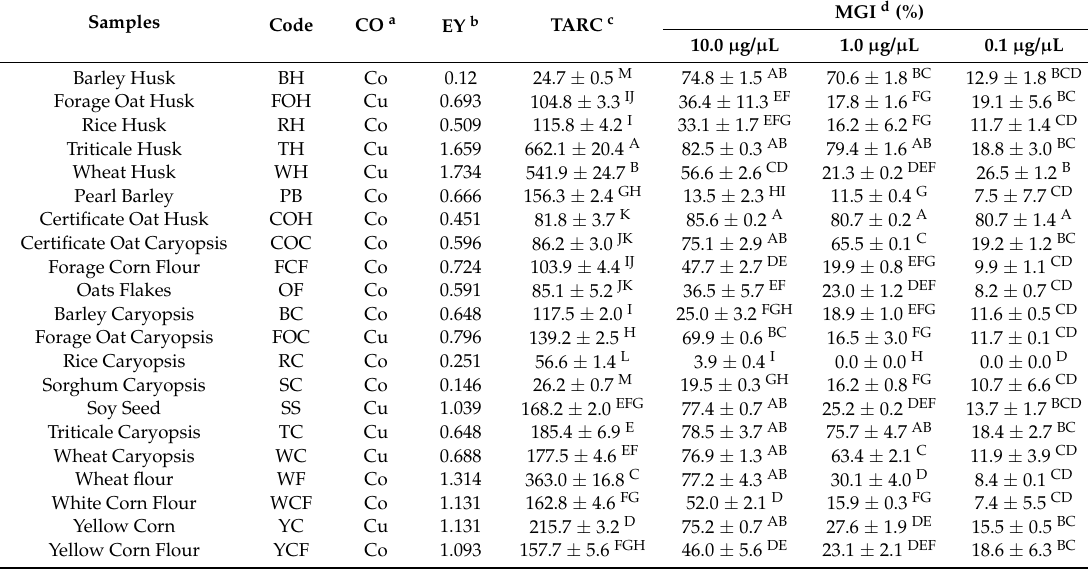
Table 2. AR quantification for each processed sample, growth inhibition for each evaluated sample at three different concentrations, and their statistical